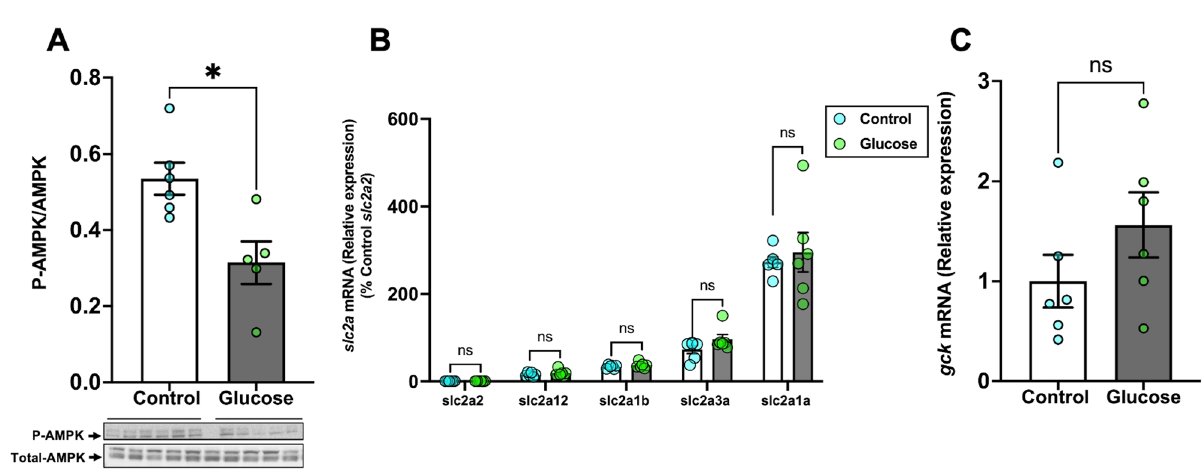
Figure 2. Glucose reduces AMPK phosphorylation in the brain. (A ) Glucose exposure decreased the ratio of phosphorylated to total AMPK (M.W.:62 kDa) in the brain compared to the control. ( B ) The transcript levels of the glucose transporters ( slc2a ’s) in the brain did not change after glucose exposure. As we were comparing relative abundance of all slc2a ’s in the brain, we chose to normalize all slc2a ’s to the slc2a 2, which showed the lowest transcript abundance. ( C ) mRNA levels of glucokinase ( gck ) remained unchanged after glucose exposure when compared to the control. Values are means ± SEM. (AMPK expression n = 5–6; Transcript abundance n = 6). ns—not significant; *( P <